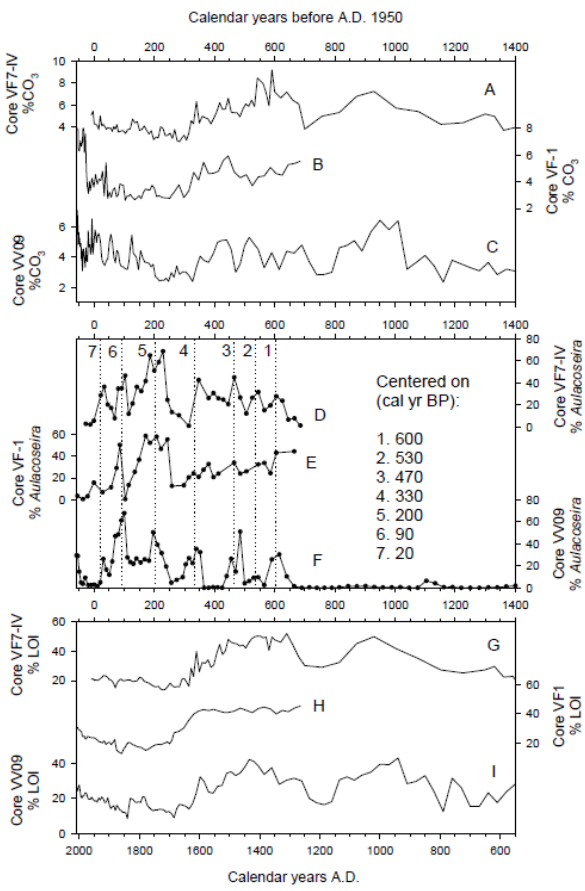
Fig. 7. Comparison of time series from the three Verlorenvlei cores. (A–C) % carbonate in VF7-IV, VF-1 and VV09, respectively. (D– F) % Aulacoseira diatoms, showing similar peaks approximately centred on the dates listed. (G–I) %LOI. The similarity of the pro- files from opposite ends of the lake supports the respective age mod- els and shows that the basic patterns of change in the cores represent lake-wide events.